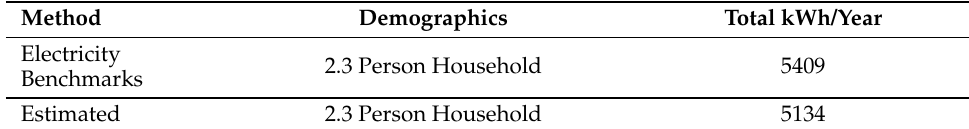
Table 6. Comparison of results using energy benchmarks.